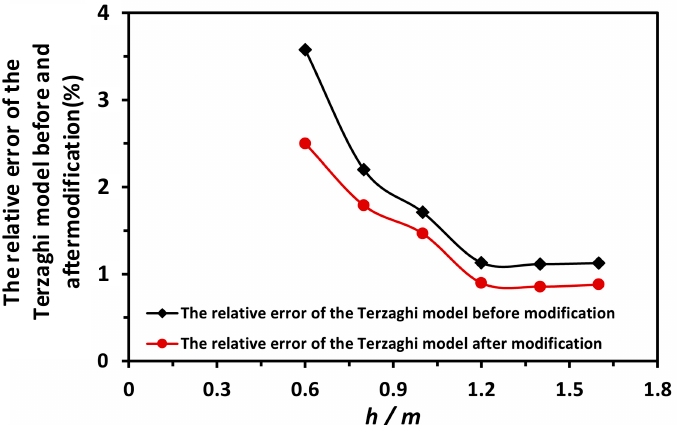
Figure 15. The relative error of the Terzaghi model before and after modification.